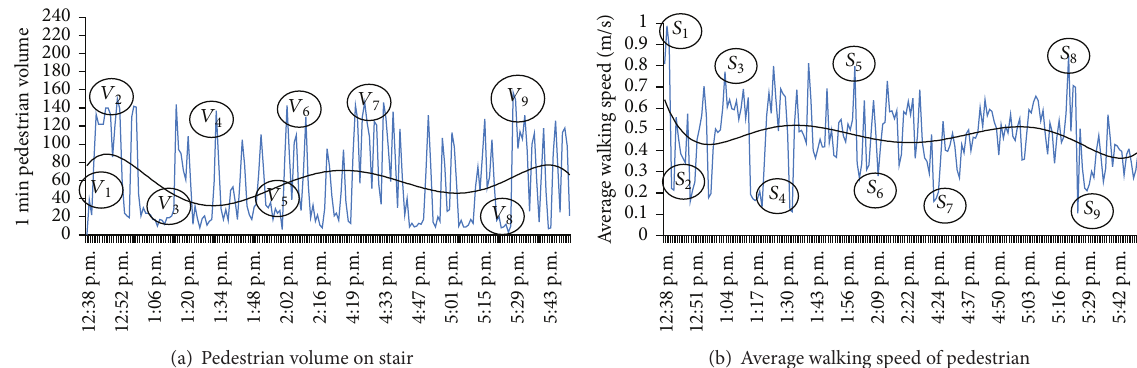
Figure 7: 1-minute pedestrian volume and average walking speed on Stair 1.